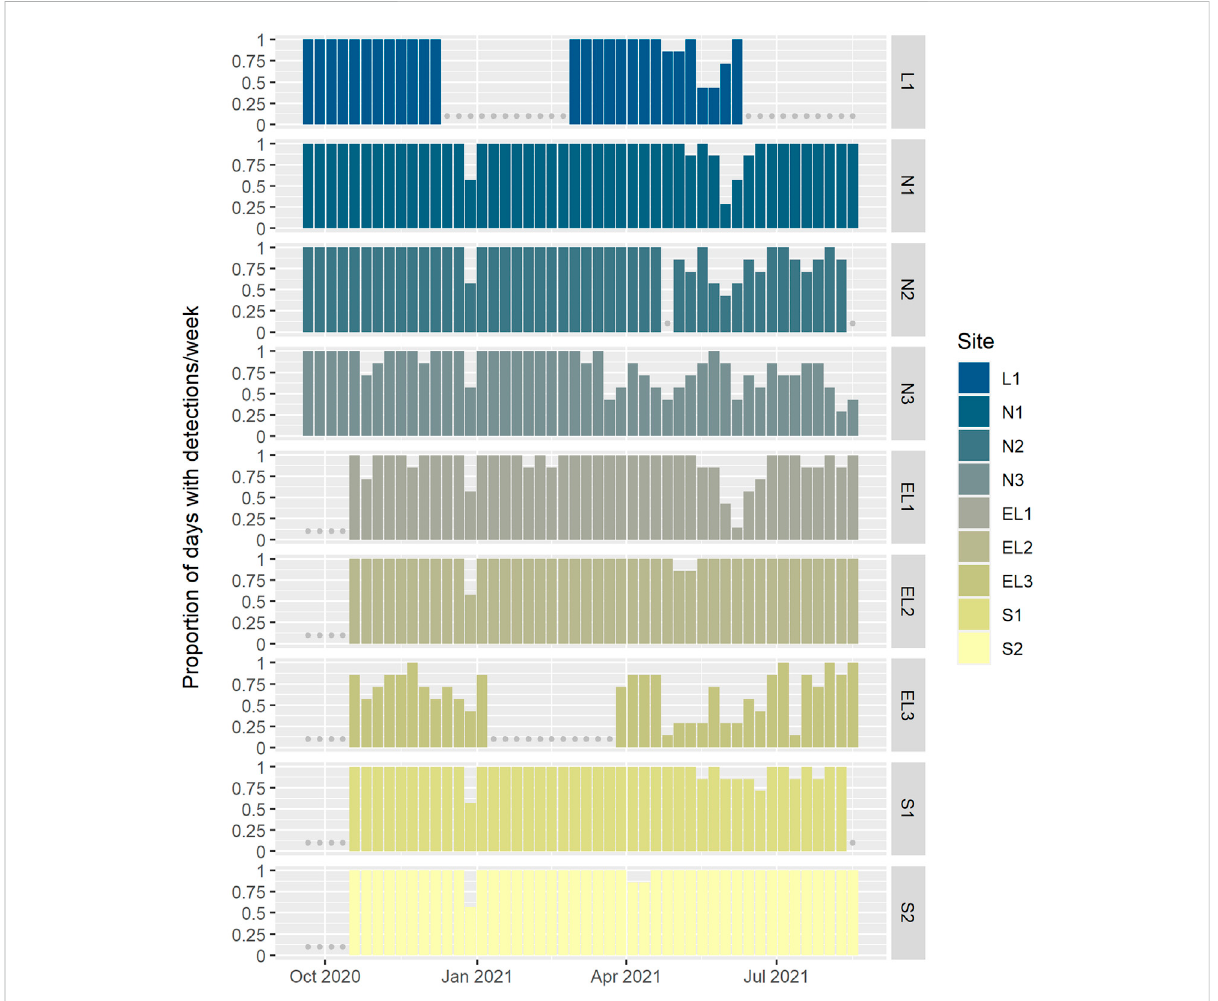
FIGURE 5 Proportion of days per week with whistle and click detections, plotted by site (arranged north to south, and offshore to coastal; see Figure 1). Detections were not classi fi ed to species and while mainly comprised of delphinid detections, they might include beaked whales too. Grey dots indicate weeks with missing